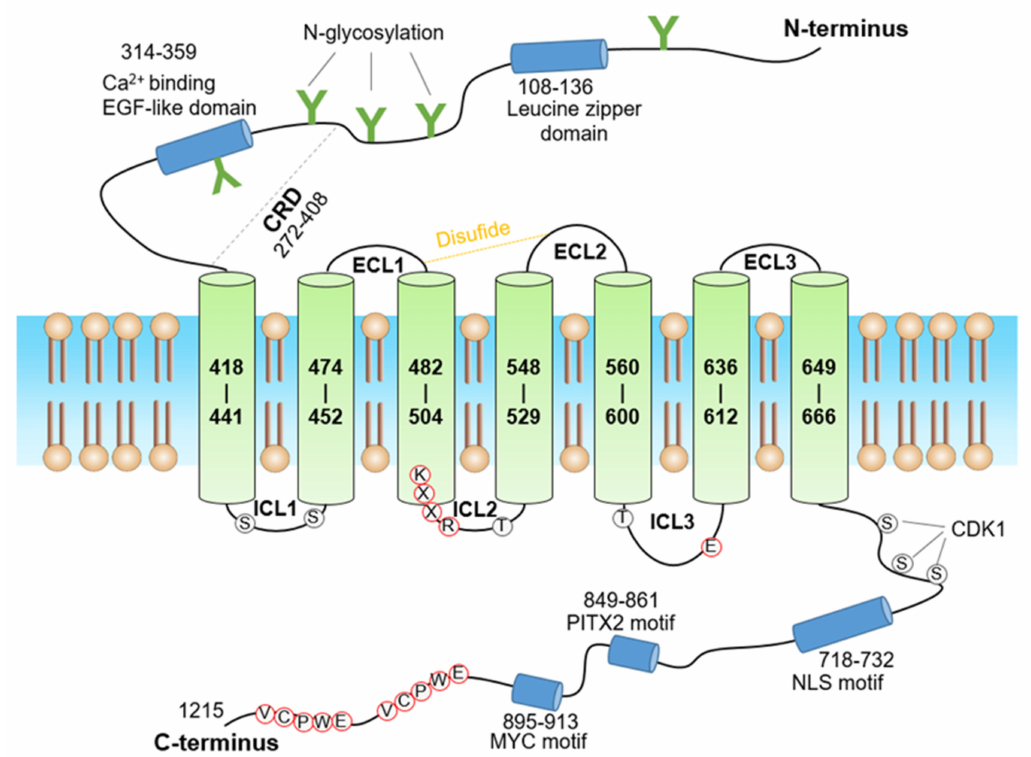
Figure 3. The schematic representation of human GPR158. The green letter “Y” indicates putative N-glycosylation sites in the N terminus. The disulfide bond in ECL1 and ECL2 is shown as a dotted yellow line. The leucine zipper domain, Ca2 + -binding EGF-like domain, NLS motif, MYC motif, and PITX2 motif, are shown as blue cylinders. The conserved VCPWE motifs in the C-terminal tail of GPR158 are shown as golden hexagons. The KXXR motif in TM3 and the residue E in ICL3, presumed to be involved in the activation of Family C GPCRs, are marked in red circles. Three serine in the C-terminal domain, the putative phosphorylation sites for CDK1, may involve in cell proliferation. The figure was modified from: GPR158, an orphan member of G protein-coupled receptor Family C: glucocorticoid stimulated expression and novel nuclear role. Patel N, et al. PLoS One. 2013 [25]; used with permission from the